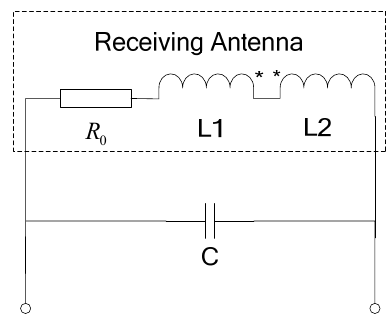
Figure 25. The equivalent resonant circuit of 8-word